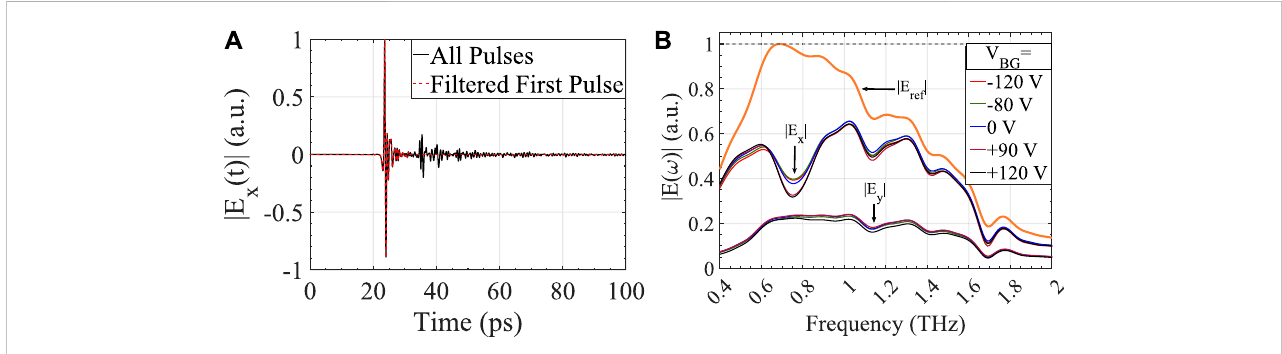
FIGURE 4 (A) Temporal THz E- fi elds normalized to the maximum value of the fi ltered fi rst pulse. (B) Spectral amplitudes of the fi rst transmitted temporal pulse at various back-gate voltages normalized with respect to the E ref. ‘ s maximum value when rotating the device by θ SR = 30 o (from the x ’ axis) and analyzer by Φ − 30 o and+60 o (fromthey ’ axis).E fi rsttemporalpulsepassingthrougha1.2×1.2 μ m 2 uniformgraphenepatchfabricatedon-chip AZ = ref. isthespectraofthe without any SRs metal features and used for referencing.